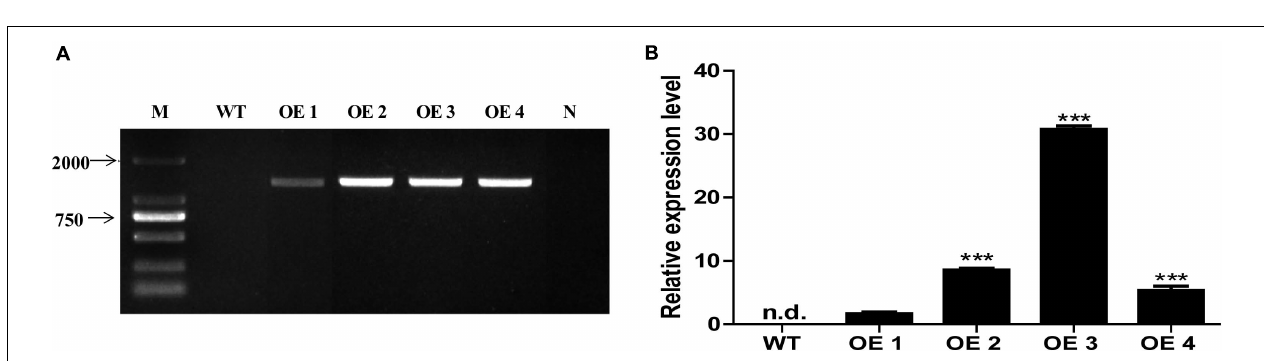
FIGURE 2 | Expression profile of H. caspica assimilating branch TOE3 gene under different abiotic stress and abscisic acid treatments: 600 mM NaCl (A) , 1,000 mM mannitol (B) , 45 ◦ C high temperature (C) , 100 µ M MV (D) , 4 ◦ C chilling injury (E) , 0 ◦ C freezing point (F) , − 2 ◦ C freezing stress (G) , 300 µ M abscisic acid (ABA) (H) . HcUBC10 served as reference gene, and the expression of HcTOE3 gene in the control (0 h) was adjusted to 1. Data represented the average of three biological replicates. Significant differences at * p < 0.05, ** p < 0.01, and *** p < 0.001.